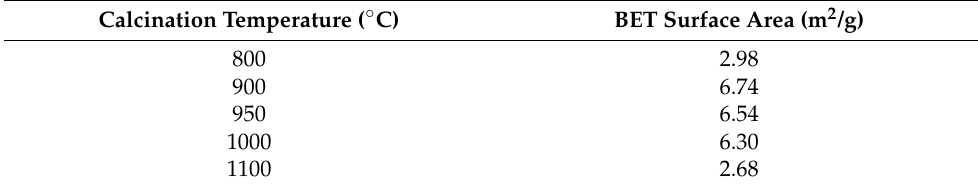
Table 1. BET surface area of calcined eggshell at different temperature.